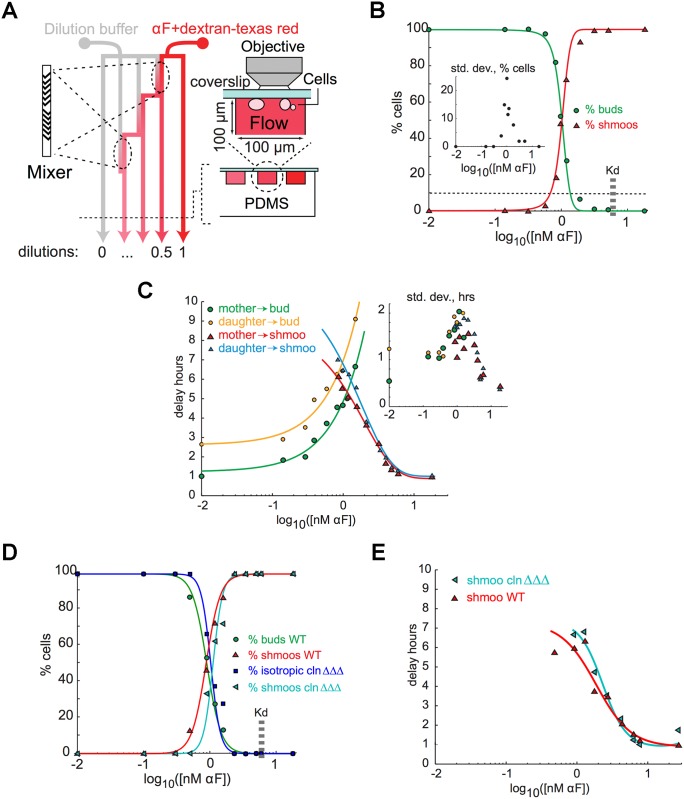
The response of bar1Δ cells response to homogenous stimulation by α-factor.A) Schematic of a device to produce a range of pheromone concentrations by using chaotic mixers in dilution chambers. The diagram shows a plan view (left) and cross sections at two magnifications (right). Structured micro channels allow fast mixing and thus permit serial dilutions in a small device. A lectin (concanavalin A) binds yeast cells to the coverslip that forms the roof of the chamber. They receive a constant flow of pheromone, allowing them to be exposed to concentrations that are stable over several hours and can be measured by quantifying the emission of a fluorescent dextran mixed with the pheromone (see Experimental Procedures in S1 Text and Fig A in S1 Text for more details). B) The behavior of cells in micro-channels at various pheromone concentrations. We assessed cell behavior at each pheromone concentration by following cells over time and overlaying differential interference contrast and Spa2-YFP images (see Fig B in S1 Text for images). The graph quantifies the bud/shmoo transition in spatially uniform fields of pheromone and summarizes data from about 4000 cells (on each curve (red and green), at least 160 cells (MP 384) were used to obtain the averages shown for each pheromone dose) in seven independent dilution chambers. The inset shows the standard deviation of the fraction of different events between experiments. The measured dissociation constant of α-factor from Ste2 is indicated (Kd) [41]. The half maximal point of the sigmoidal fit is 1.02 ± 0.03 nM and the Hill coefficient for the transition between budding and shmooing is 6.5 ± 0.6 (95% confidence interval). C) Quantification of polarization delays. Time was measured from the end of the first cytokinesis after the onset of pheromone treatment. Cells were considered polarized when a stable focused Spa2 cap was formed. Only those cells whose progenitors had completed cytokinesis during the first three hours after the start of pheromone treatment were considered. At least 52 cells (MP 384) were used to obtain the averages shown for each point. D and E) Cells arrested in G1 by G1 cyclin depletion were placed in exponential dilution chambers together with wild type cycling cells (using a fluorescent cell wall marker to distinguish the two strains). Experiments and measures are similar to those shown in B) and C). The transition to shmooing occurs at exactly the same concentration for G1 arrested and cycling cells (G1 arrested cells that do not shmoo grow isotropically, forming large spherical cells). Because Cln-depleted cannot leave G1 and cells arrested in G1 never polarize except when they form a shmoo, we do not show the delay before rebudding for wild type cells. The delay before shmooing is similar for cycling cells and for G1-arrested cells. In graph D) each point corresponds to an average value computed over 66 cells (MP 384 and MP 1333) and in graph E) over 52 cells (MP 384 and MP 1333).